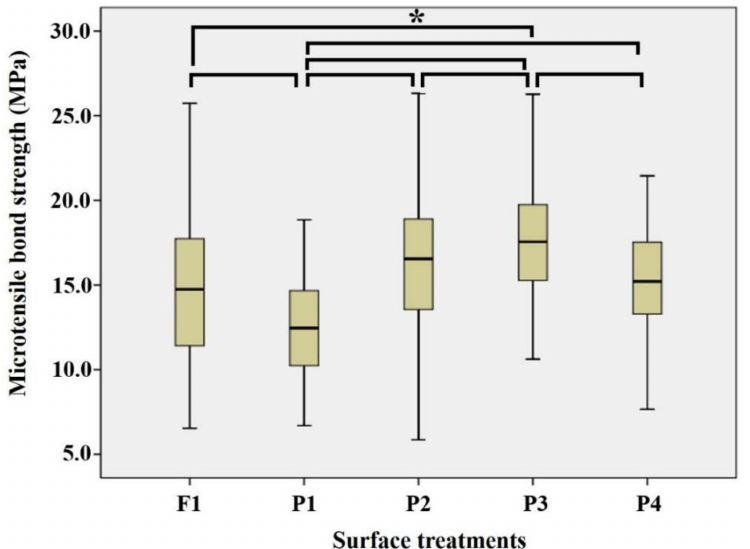
Figure 3. The statistical analysis of the surface treatment regardless of the resin cement used. The mean MTBS value of P3 (surface treatment of the PEKK posts with a silica coating and silanes) showed the highest statistically significant value and compared to the other surface treatment groups. It was followed by P2, R4, F1, and P1. There was no statistically significant difference between P2, P4, and F1. *: statistically significant.